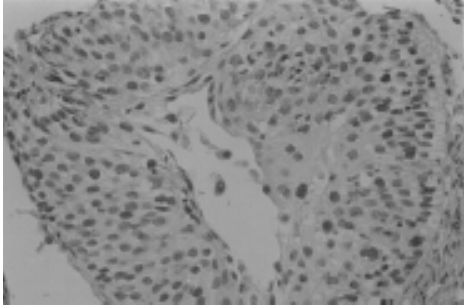
Figure 1. Positive immunohis- tochemistry staining for c-myc demonstrating nuclear reactiv- ity. Magnification 400X.